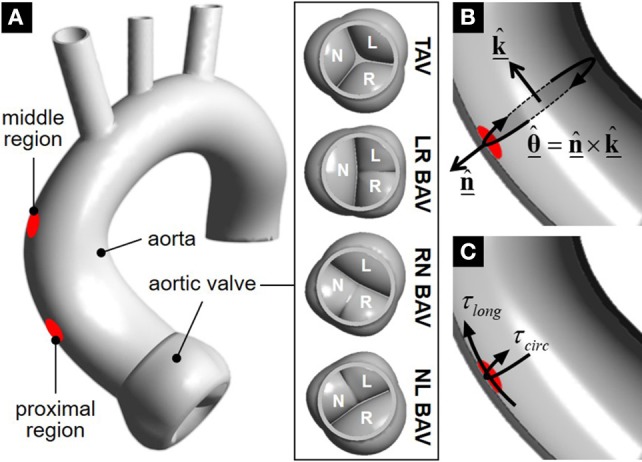
Geometrical models and WSS extraction: (A) valve-aorta models and WSS interrogation regions; (B) longitudinal (k-^) and circumferential (θ-^) direction definitions; and (C) extracted WSS components.